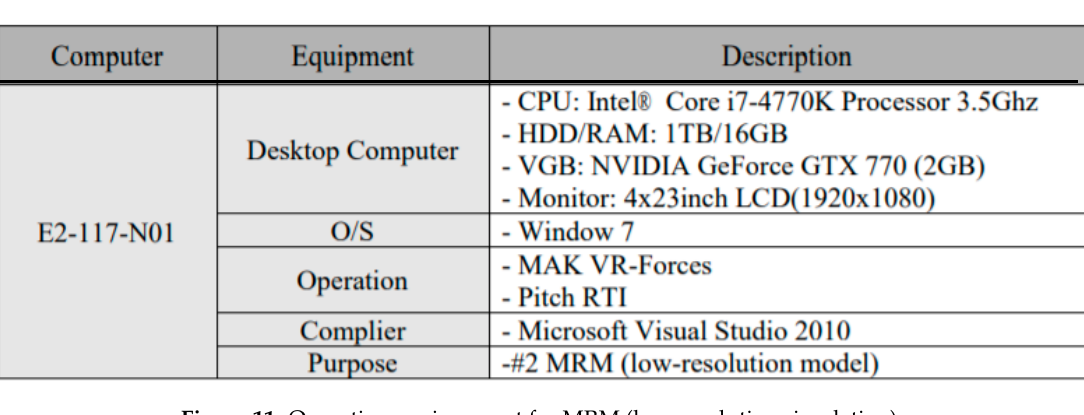
Figure 10. Arrangement of computers in UCF SIL.